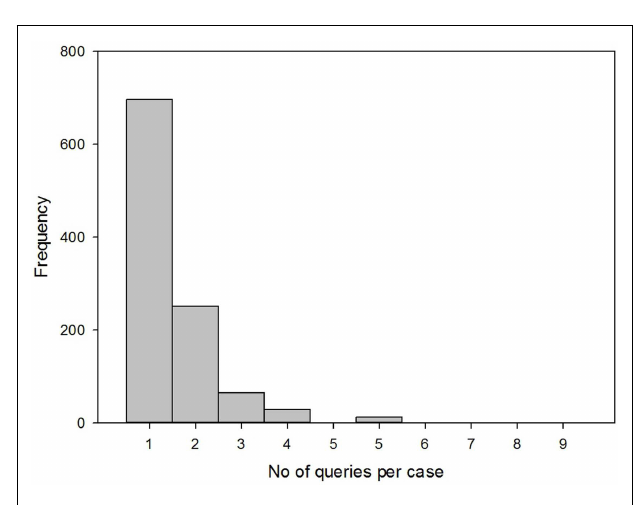
FIGURE 4 | Number of queries per case